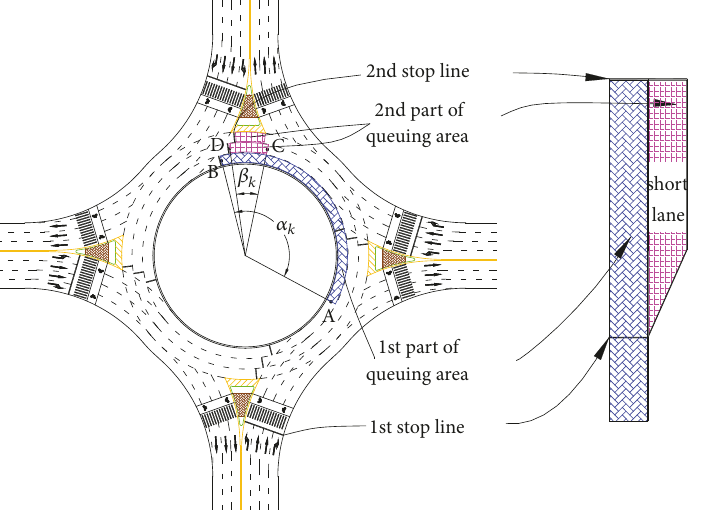
Figure 5: Short-lane analysis of right-turn